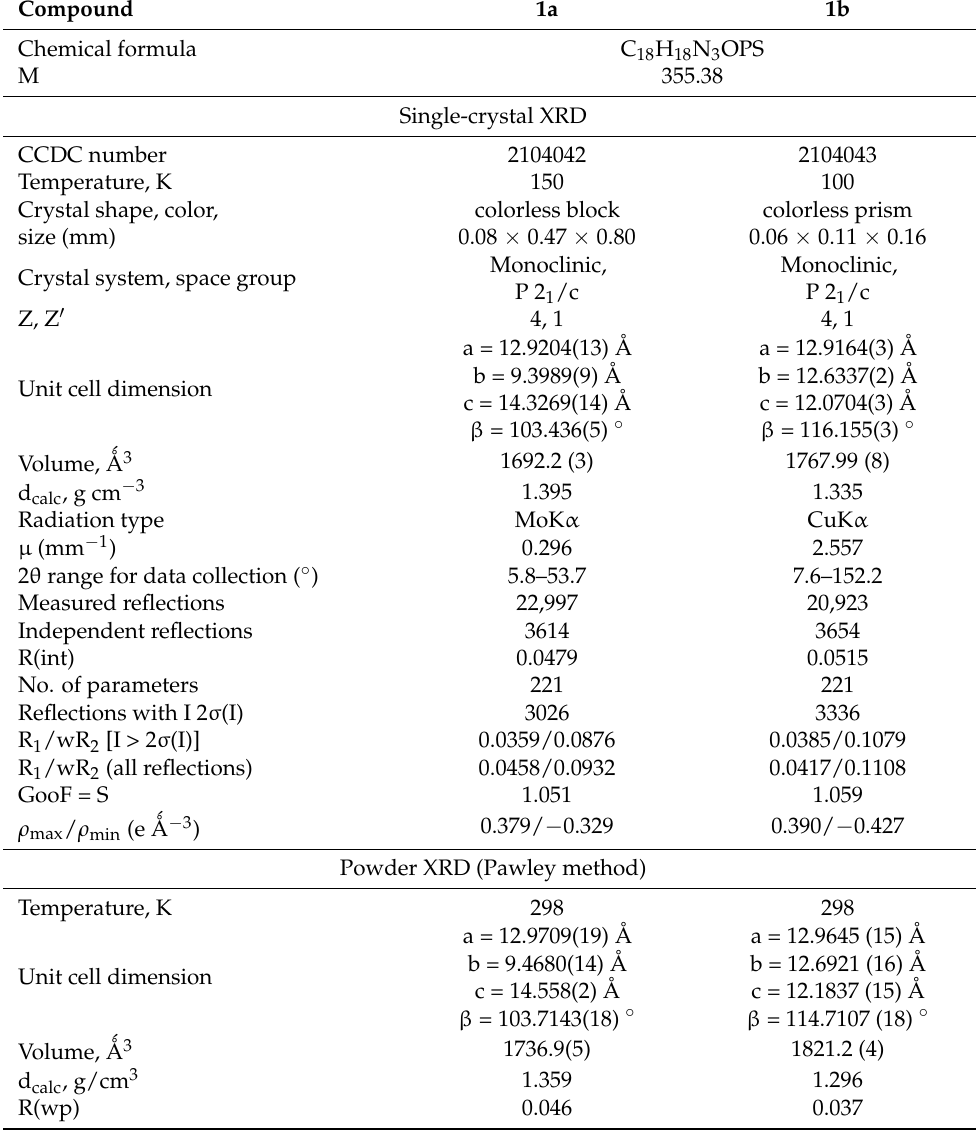
Table 1. Experimental crystallographic data and refinement parameters for crystals 1a and 1b .